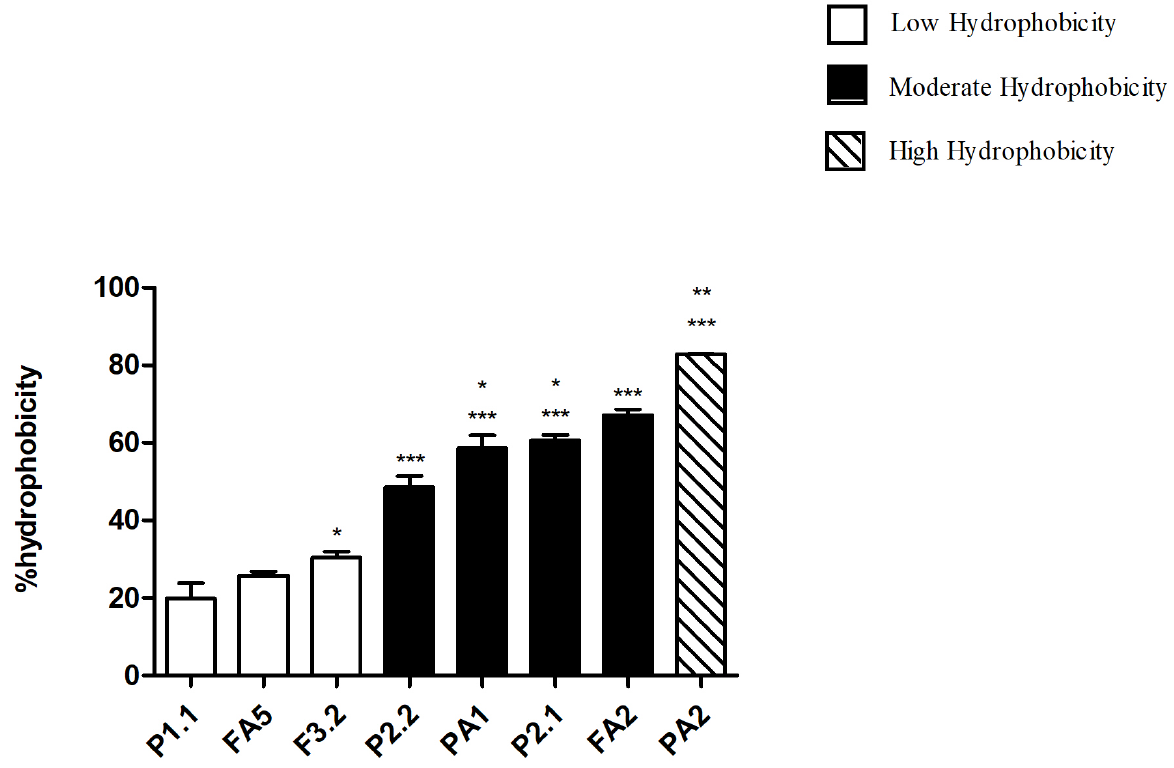
Figure 2. Self-aggregation after 5 hours of incubation. The ability of lactobacilli to aggregate among themselves was evaluated by obtaining the absorbance value before and after 5 hours of incubation of bacterial suspensions. (*) represents statistical difference of p<0.05 and (**) represents statistical difference of p<0.01. P2.1 and PA1 are statistically different from FA5 (*) and F3.2 (**); P2.2, FA2 and PA2 are statistically different from F3.2